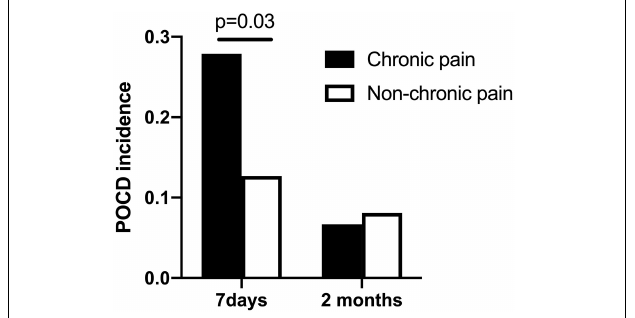
FIGURE 2 | POCD incidence at 7 days and 2 months after surgery (chronic pain patients vs. non-chronic pain